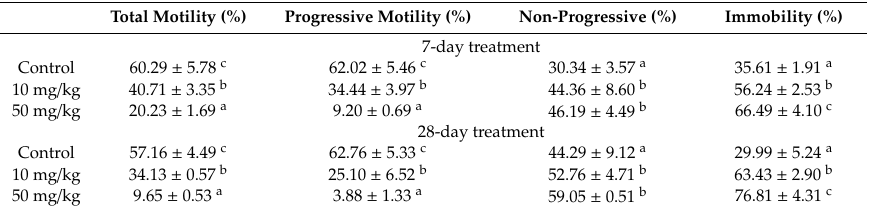
Table 5. E ff ects of sub-dermal administration of Ag-NP on sperm motility in male rats.